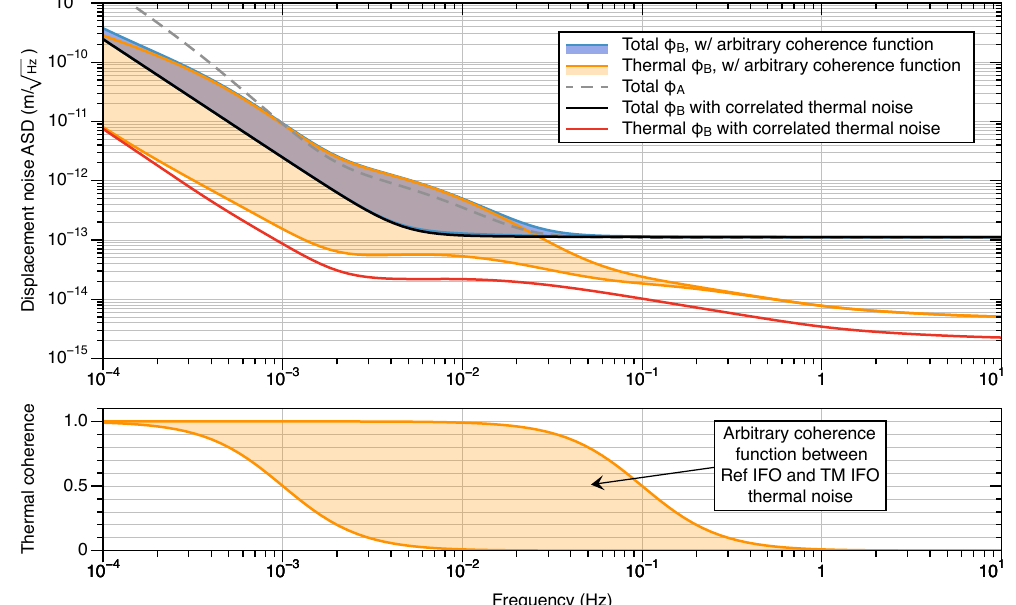
Figure A2. Influence of an arbitrary correlation in temperature noise between TM IFO and Ref IFO on the performance of the dual-OH setup. The coherence function is assumed to take the form (cid:112) 1/ 1 + ( f / f 0 ) 2 , where f is the Fourier frequency and f 0 is the cut-off frequency, yielding perfect correlation at frequencies f (cid:28) f 0 , and total uncorrelation at frequencies f (cid:29) f 0 . In this example we show the resulting displacement noise for an arbitrarily distributed coherence function with f 0 ∈ ( 10 − 3 ,10 − 1 )